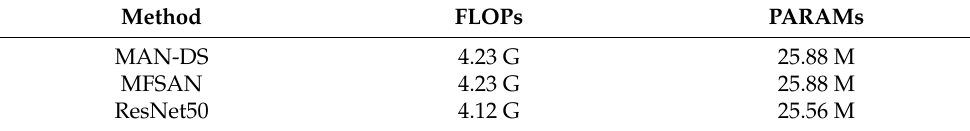
Table 5. FLOPs and